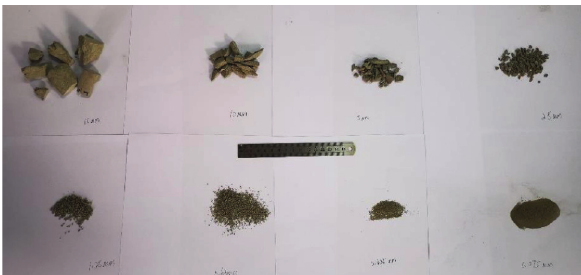
Figure 8: Screening diagram of crushed specimens. Table 1: Fragment mass distribution of SHPB experimental specimens.